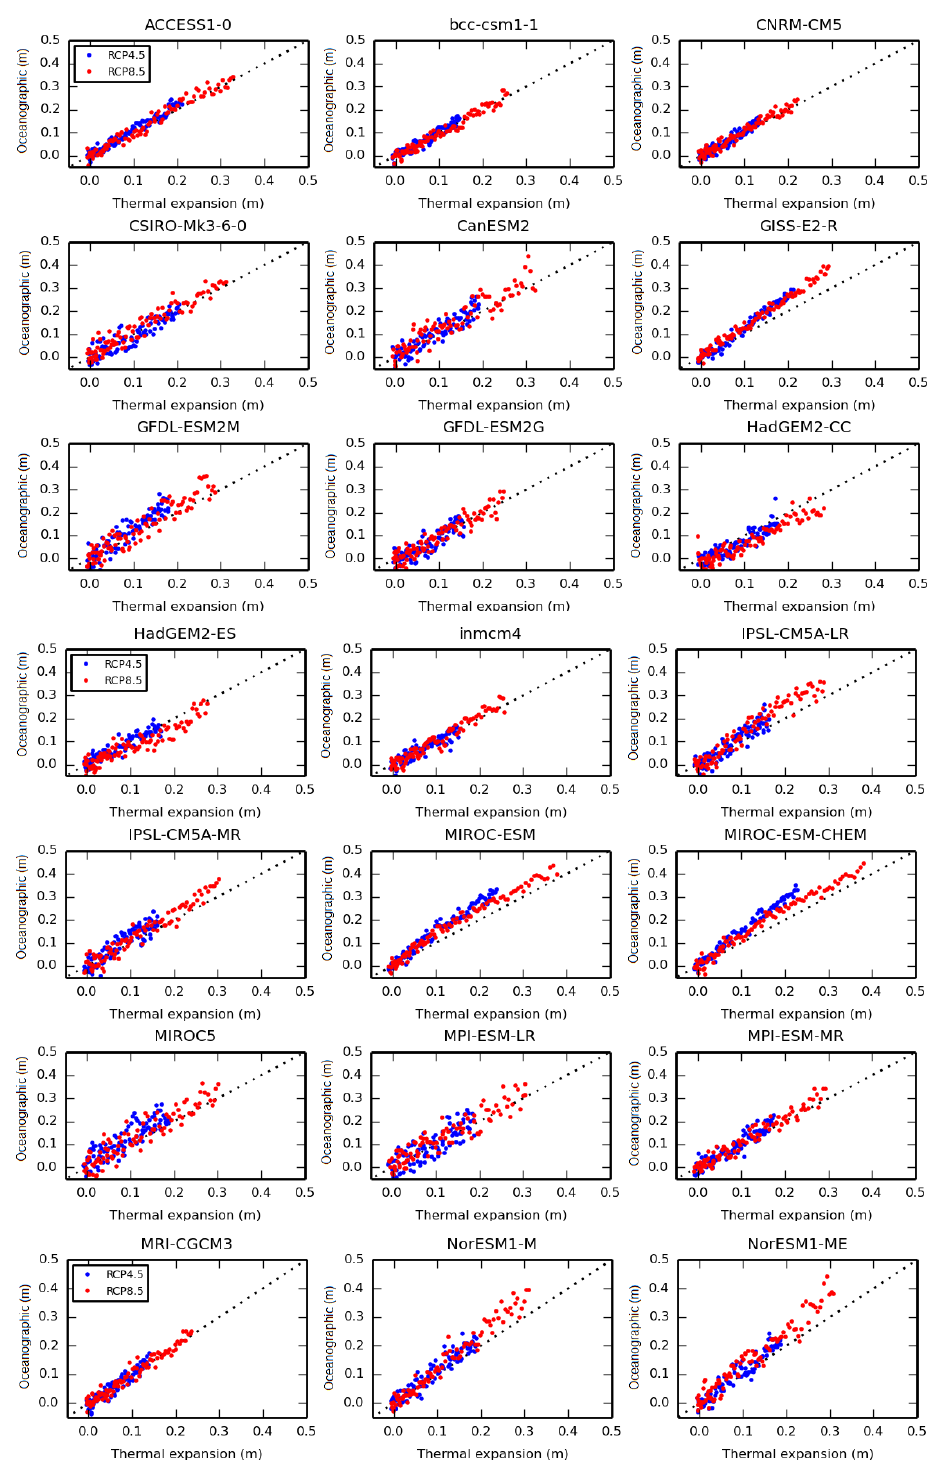
Figure A1. Regression between local oceanographic sea level change (due to steric plus dynamic processes) and global thermal expansion terms for each CMIP5 model under RCP4.5 and